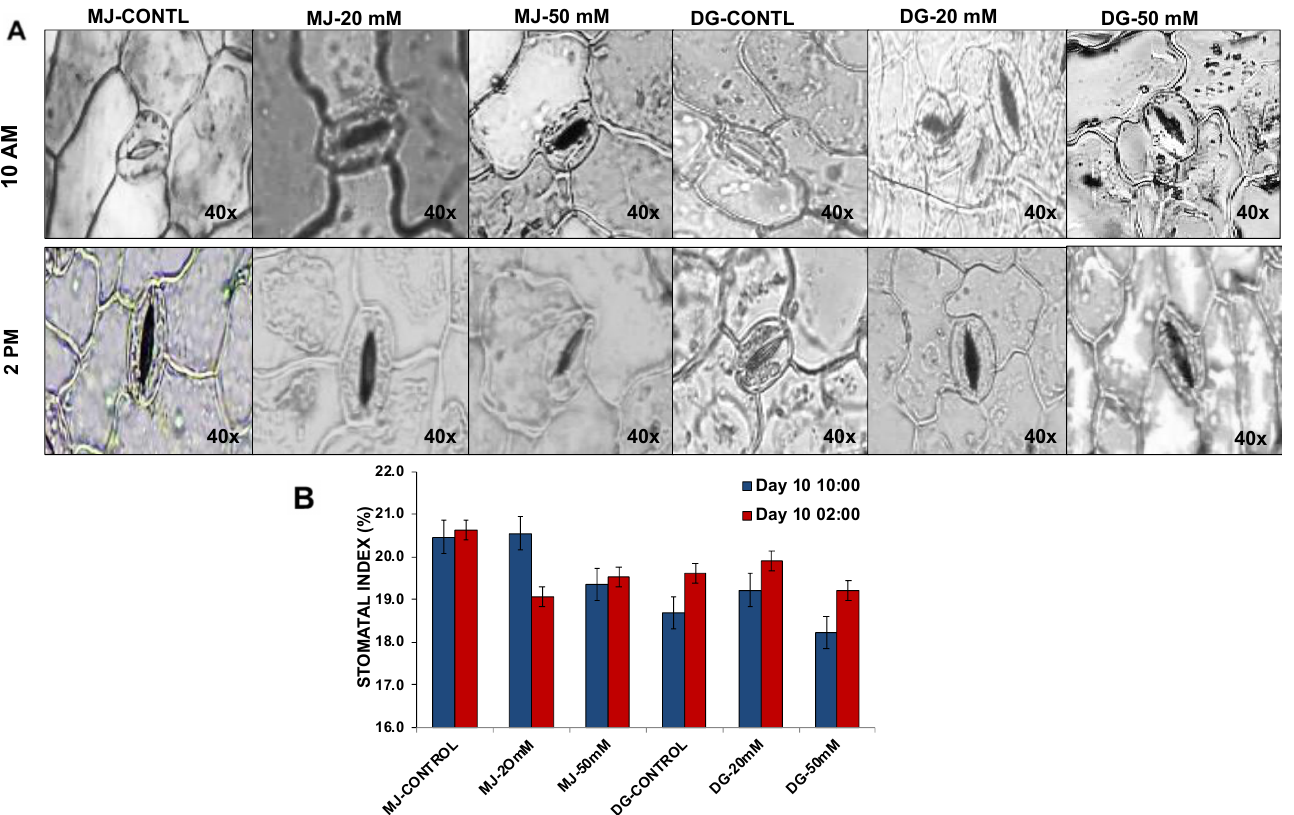
Figure 10. ( A ) Stomatal structure and ( B ) stomatal index in spinach genotypes Delhi green (DG) and Malav Jyoti (MJ). Results are presented for controls (MJ control; DG control), 20 mM of NaCl treatments (MJ-20 mM; DG-20 mM), and 50 mM of NaCl treatments (MJ-50 mM; DG-50 mM). Sampling was performed (on the basis of the circadian cycle) at 4 h intervals which corresponded to the exact times of 10 am, and 2 pm on day 10 of salinity stress. Vertical bars indicate mean ± S.E. for n = 3. The blue color bars in the graph indicate day 5 and the red color bars indicate day 10.